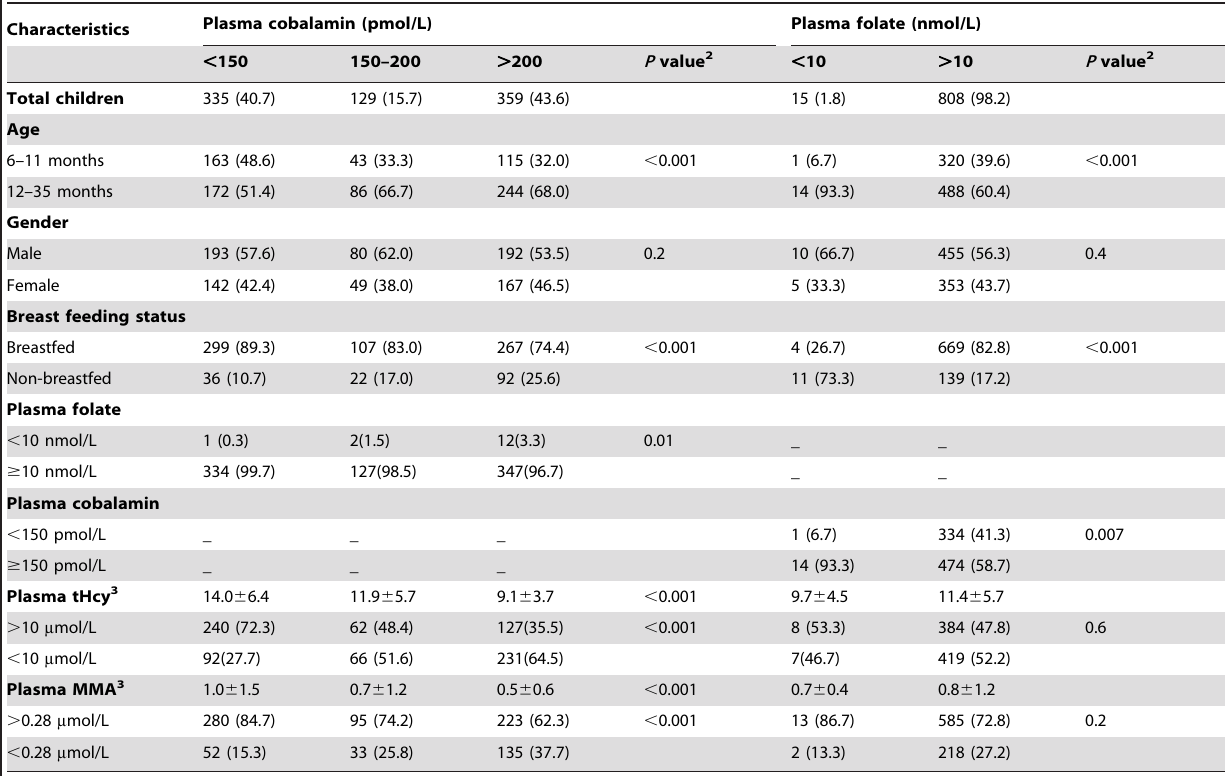
Table 4. Cobalamin and folate concentrations in the study children according to age, gender, breastfeeding status and their metabolic markers.